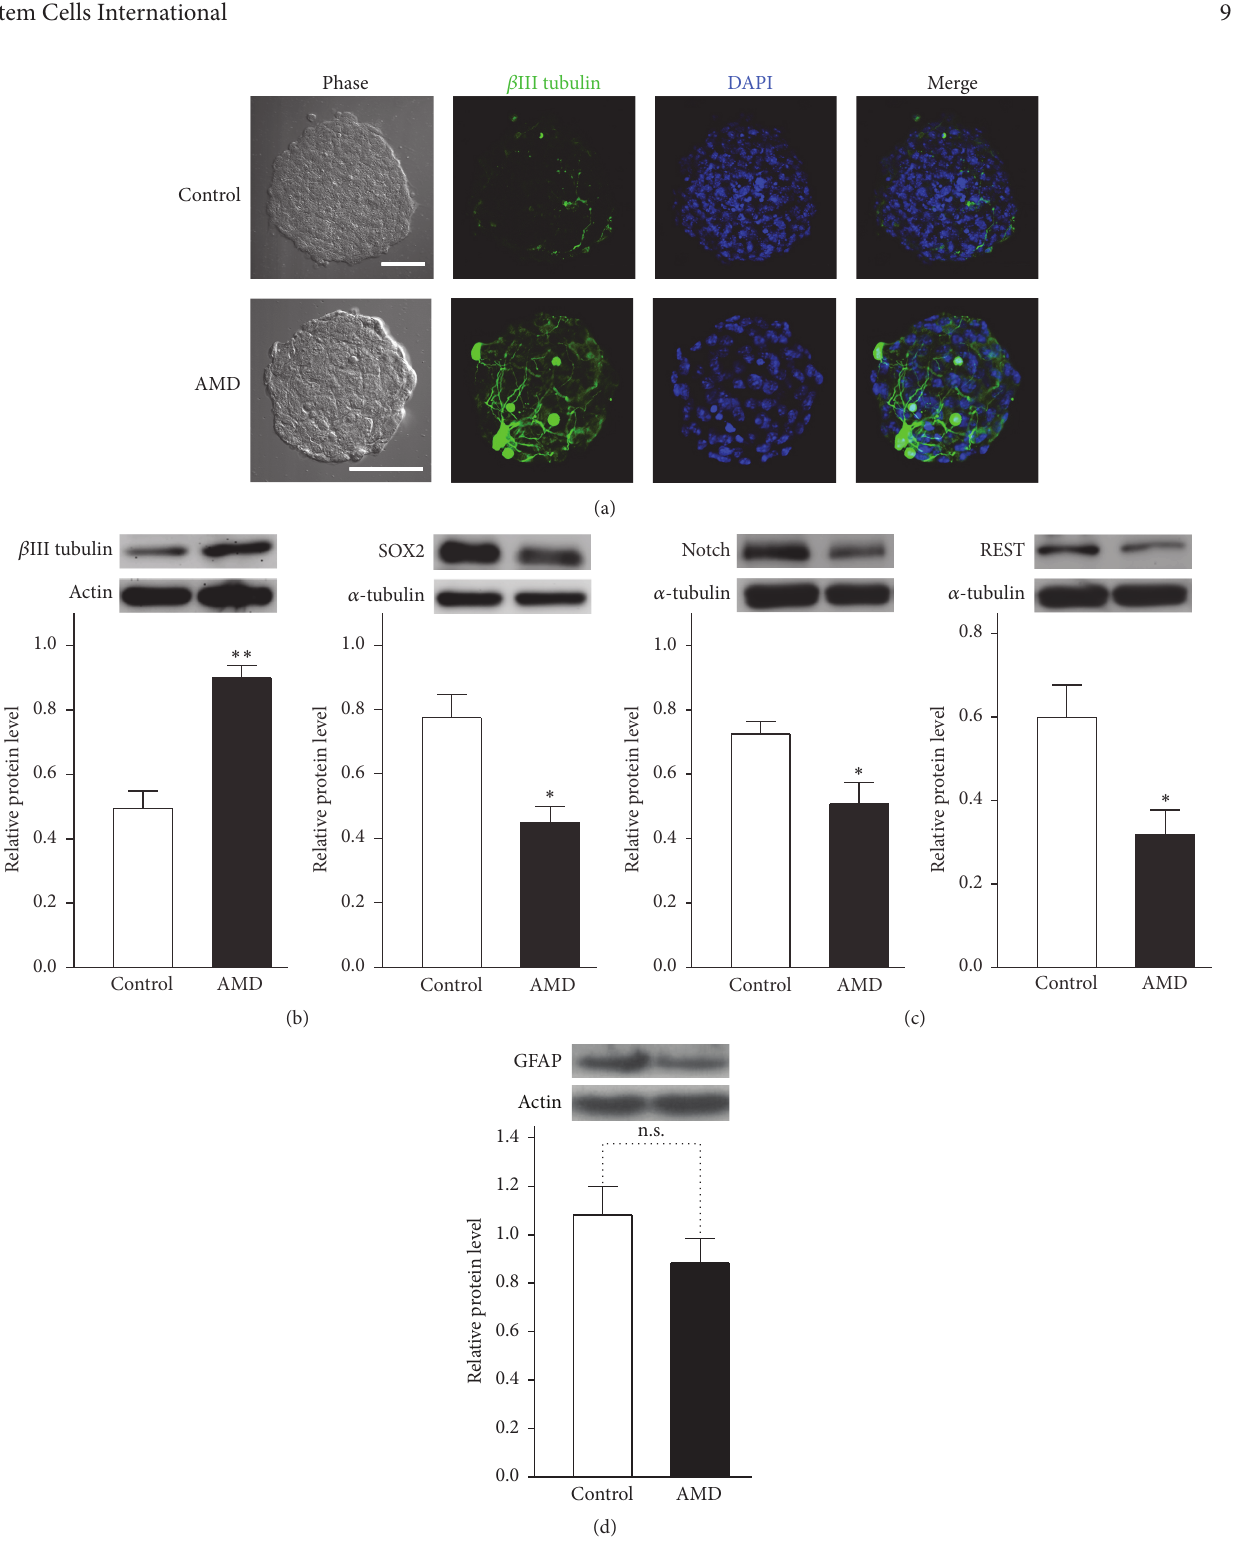
Figure 5: Inhibition of SDF-1/CXCR4 signaling cascades promoted the neuronal lineage differentiation. (a) Confocal microscopic images of 𝛽 III tubulin + (green) cells in the 6DIV neurospheres after PBS or AMD incubation. Scale bar, 50 𝜇 m. ((b), (c), and (d)) Western blot of total cell lysates was obtained from mouse primary neurospheres cultures treated with PBS or AMD (1 𝜇 g/mL) for 6 days. Antibodies selectively recognizing 𝛽 III tubulin, SOX2, Notch, REST, and GFAP were used. The neurospheres treated with AMD showed a significant increase in 𝛽 III tubulin and Notch. In contrast, the immunodensity exhibited a dramatic downregulation of SOX2 and REST levels after CXCR4 blockage. However, the GFAP protein levels were unchanged after AMD treatment. Results are representative of three independent experiments with neurospheres from three independent litters. Data represent the mean ± SEM, n.s.: no significant, ∗ 𝑝 < 0.05 , ∗∗ 𝑝 < 0.01 , Student’s 𝑡